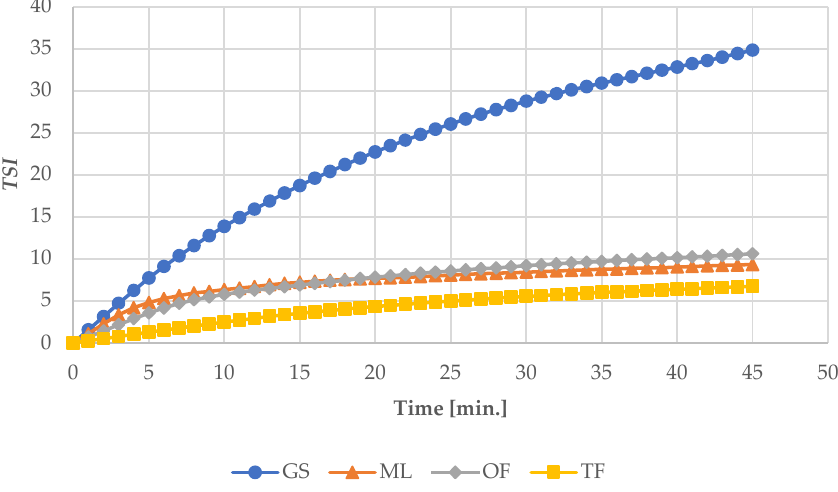
Figure 6. Changes in the TSI over time during the heating of individual syrups used in the production of high-protein bars being the subject of implementation.